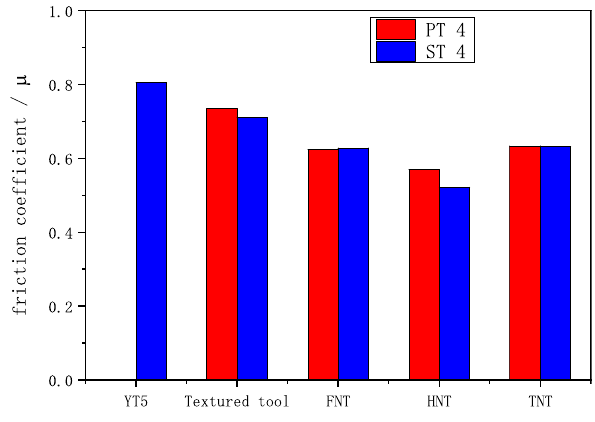
Figure 5: Friction coe ffi cient of di ff erent tools ( FNT - 50 nm coated textured tool, HNT - 100 nm coated textured tool, and TNT 200 nm coated textured tool )